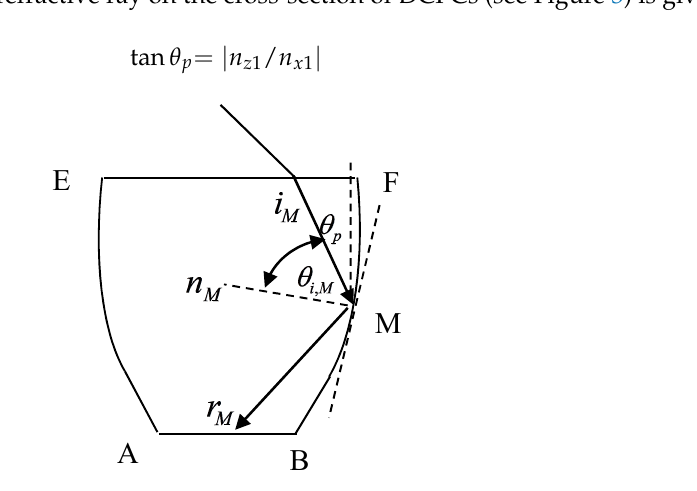
Figure 3. Incident angle of solar rays on the internal wall of Figure 3 . Incident angle of solar rays on the internal wall of DCPCs.